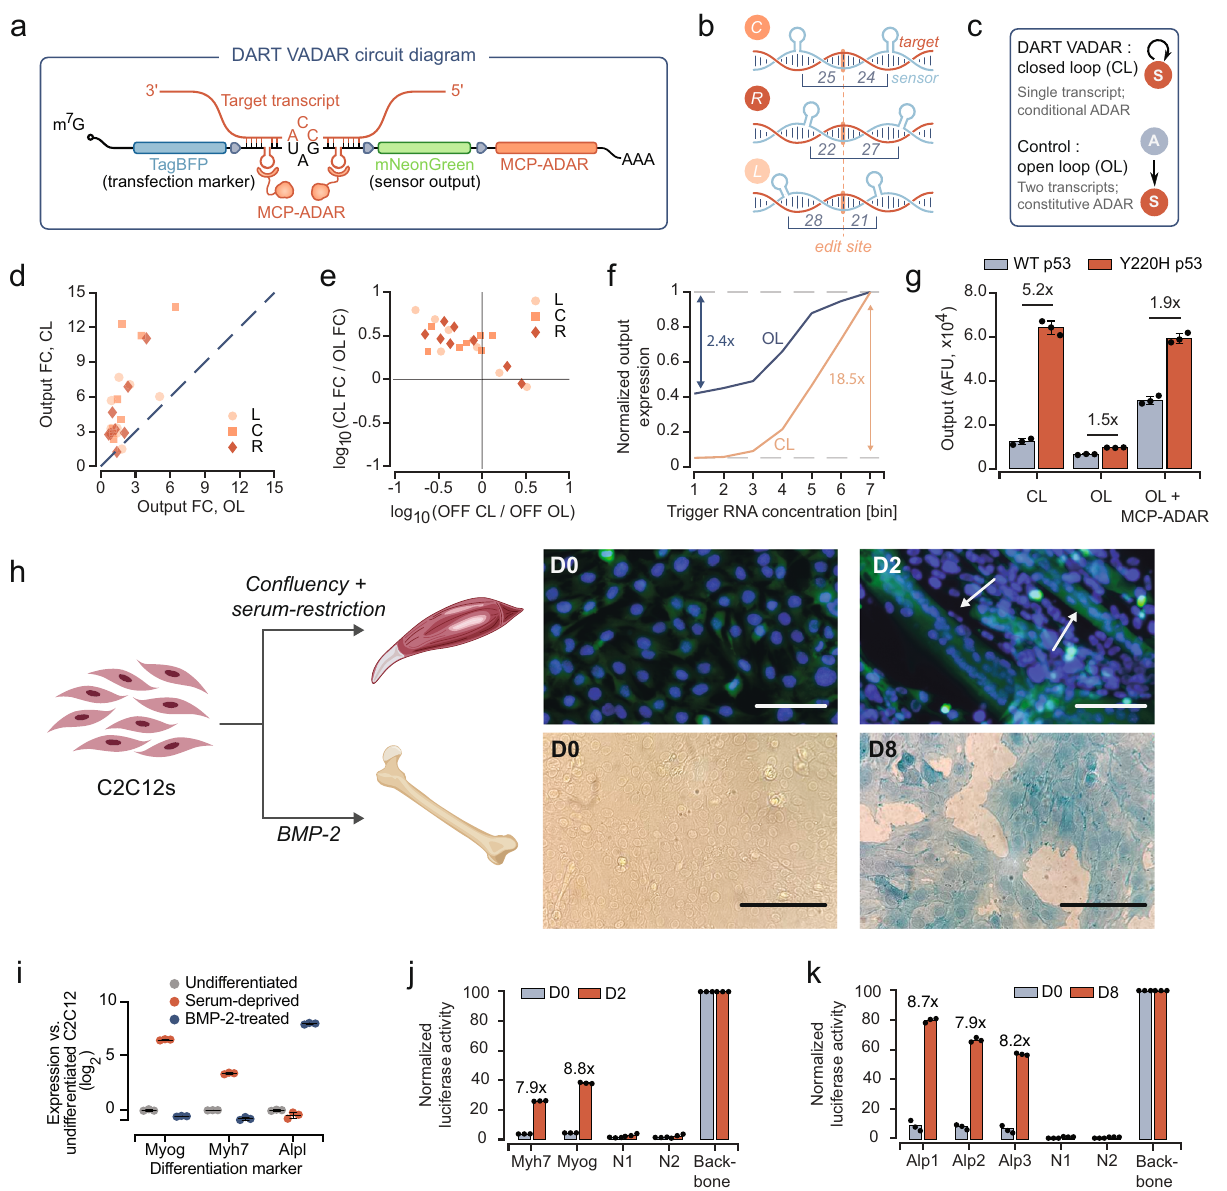
Fig. 3 | Autocatalytic DART VADAR sensors are responsive, speci fi c, and sen- sitive. a Schematic illustrating the DART VADAR circuit design. b We modi fi ed ADAR-based sensors by adding fl anking MS2 hairpins in three con fi gurations. Numericannotationscorrespondtothenumberofbasepairsbetweentheeditsite andMS2hairpin.L,left;R,right;C,center. c Asitformsanautocatalyticloop,DART VADARisaclosed-loop(CL)system.WebenchmarkedDARTVADAR ’ sperformance against an open-loop (OL) control, in which ADAR is constitutively expressed in trans. d The fold-change (FC) of the geometric mean of mNeonGreen expression levels is plotted for OL and CL variants. Points above the dashed line represent sensorsthatperformbetterwithautocatalysis. e Closed-loopsensorswithnegative x-axis (basal activity ratio, CL to OL) values demonstrated a reduction of back- groundsensoractivation,andclosed-loopsensorswithpositive y -axis(fold-change ratio, CL to OL) values showed an increase in dynamic range. f Open- and closed- loop sensorshave differenttransfercurvesforagivensensorexpressionlevel. The iRFP720 bin #1 corresponds to a “ no-trigger ” condition. For each variant, expres- sionisnormalizedtothemaximalsensoractivation. g DARTVADARsensorscanbe designed to speci fi cally activate in response to a point mutation ( n =3 biological